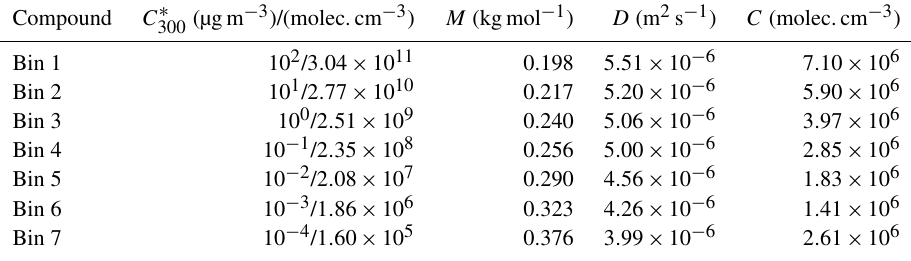
Table 2. The properties of model compounds in groups I, II and III, for Case 2. Concentrations are from measurements of Mohr et al. (2019). Saturation concentrations at 300K ( C ∗ ) are calculated using parametrization by Li et al. (2016) and converted to the ambient temperature 300 in the model based on temperature dependence by Epstein et al. (2010). M is molar mass, D gas-phase diffusion coefficient and C gas-phase